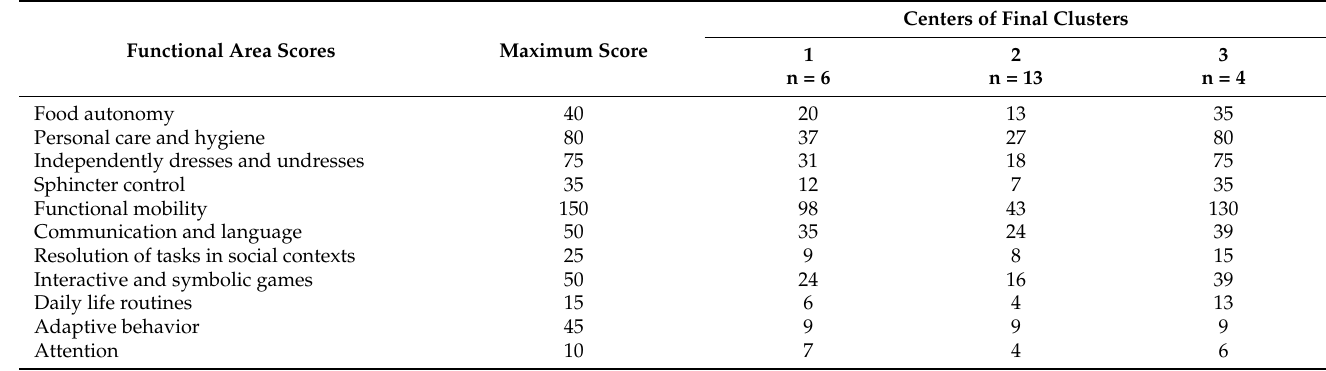
Table 4. Centers of final clusters in the 11 functional areas measured by SFA included in the eEarlyCare-T web